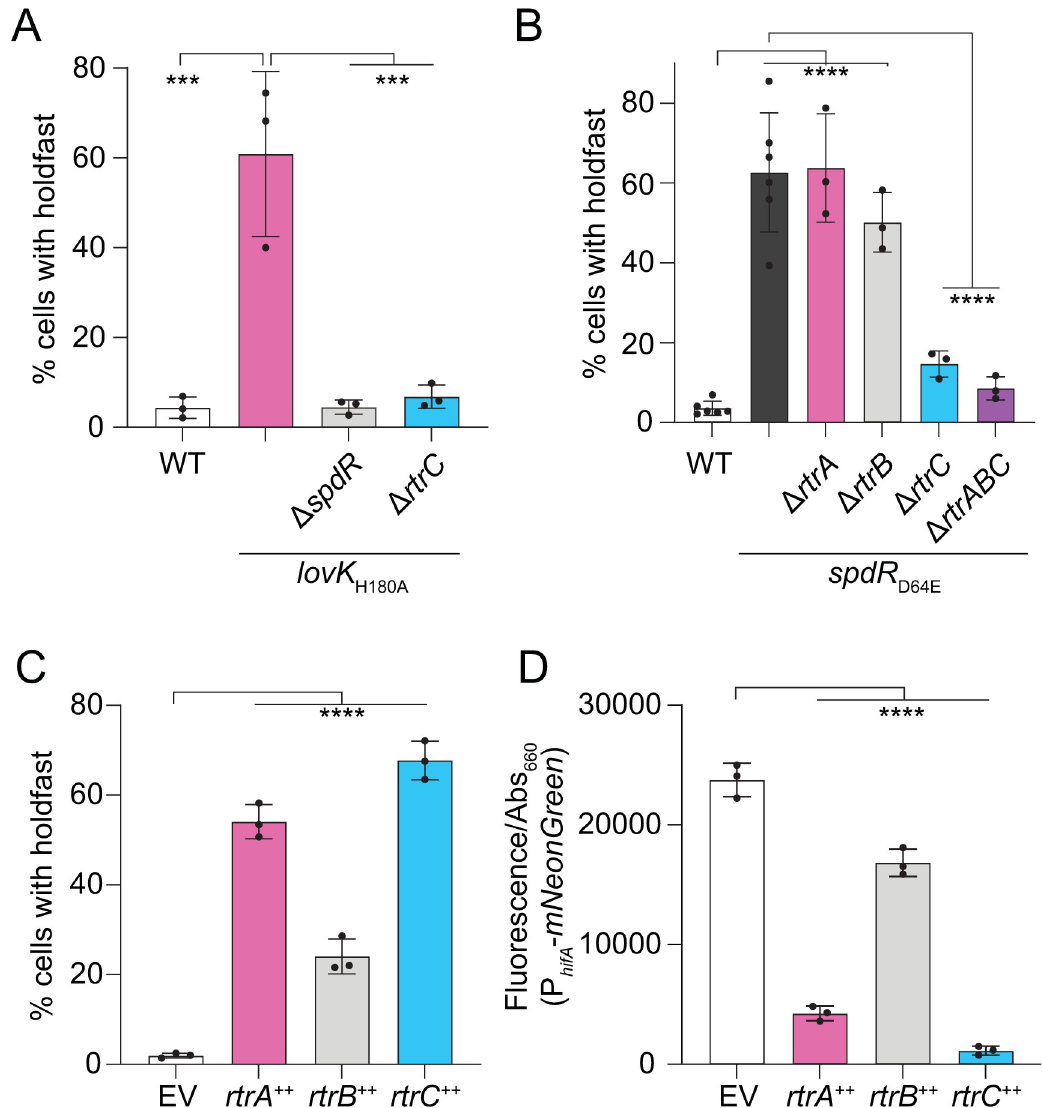
Fig 2. CCNA_00551 ( rtrC ) regulates holdfast synthesis and hfiA expression. A) Percentage of cells with stained holdfast in wild type (WT) or lovK H180A strains bearing in-frame deletions ( Δ ) in spdR and CCNA_00551 ( rtrC ). B) Percentage of cells with stained holdfast in WT, spdR D64E , or spdR D64E strains bearing in-frame deletions in rtrA , rtrB , and rtrC . C) Percentage of cells with stained holdfasts in empty vector (EV), rtrA , rtrB , and rtrC overexpression (++) backgrounds. A-C) Stained holdfasts were quantified by fluorescence microscopy. D) hfiA transcription in EV, rtrA , rtrB , and rtrC overexpression (++) backgrounds as measured using a P - mNeonGreen fluorescent reporter. A-D) Strains were grown in M2-xylose defined medium. Fluorescence hfiA was normalized to cell density; data show the mean fluorescence. Error bars are standard deviation of three biological replicates, except WT and spdR D64E in panel B, which have six biological replicates. Statistical significance was determined by one-way ANOVA followed by A-B) Tukey’s multiple comparisons test or C-D) Dunnett’s multiple comparison (p-value � 0.001, ��� ; p-value � 0.0001, ����